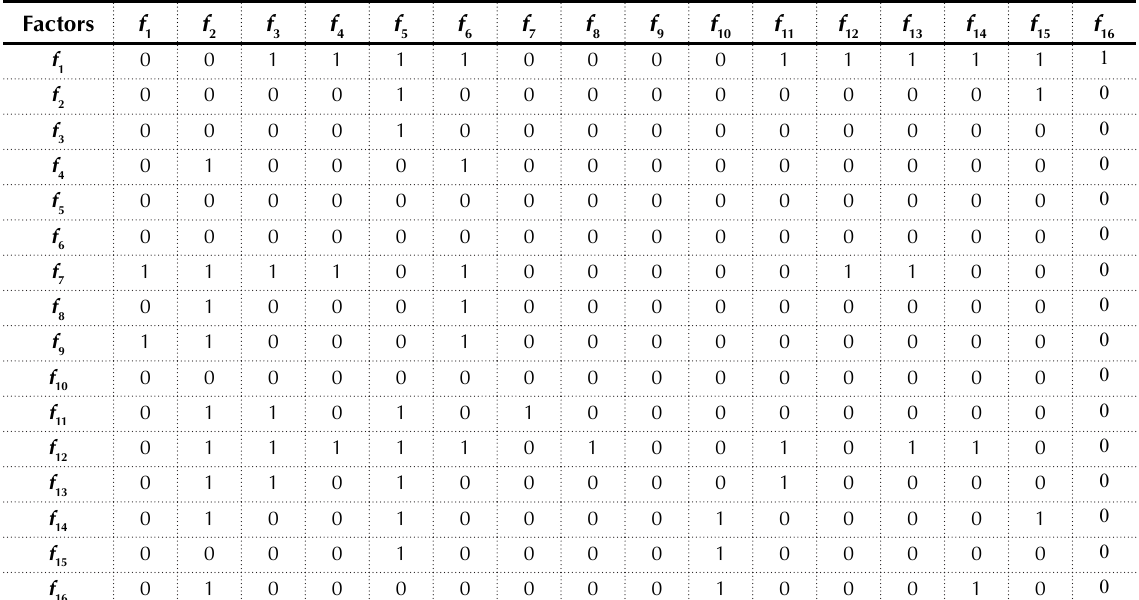
Source: Compiled by the